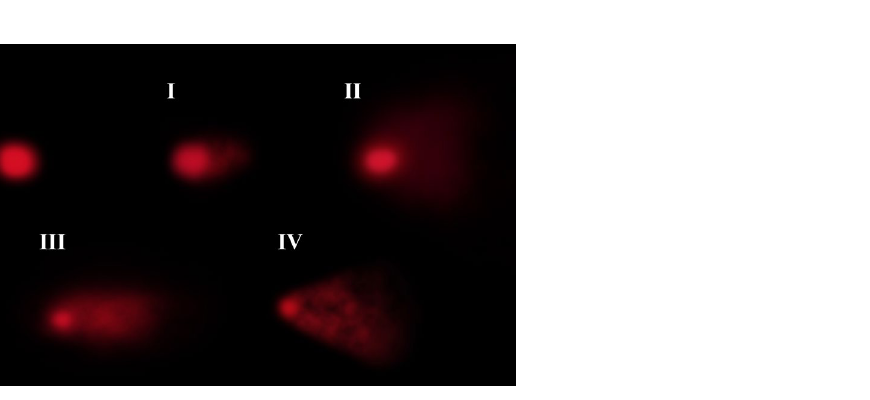
Figure 3. Effects of pendimethalin on DNA in A. cepa root tip cells nuclei ( 0 : < 2% tail percentage, I : 2–25% tail percentage, II : > 25–45% tail percentage, III : > 45–70% tail percentage, IV : > 70% tail